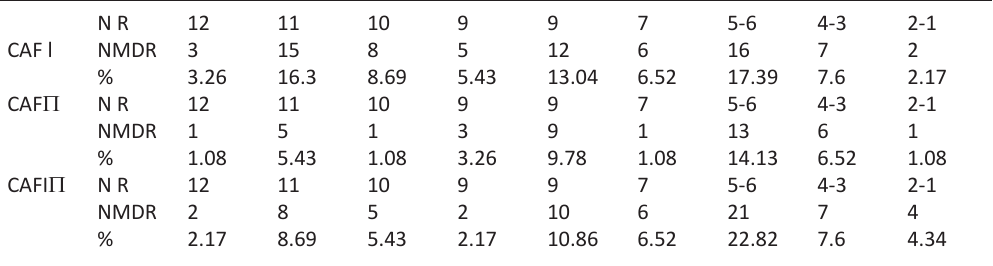
Table 4. The percentage of correlation between colony adhesion factors and multidrug resistance pattern of all E. coli isolates